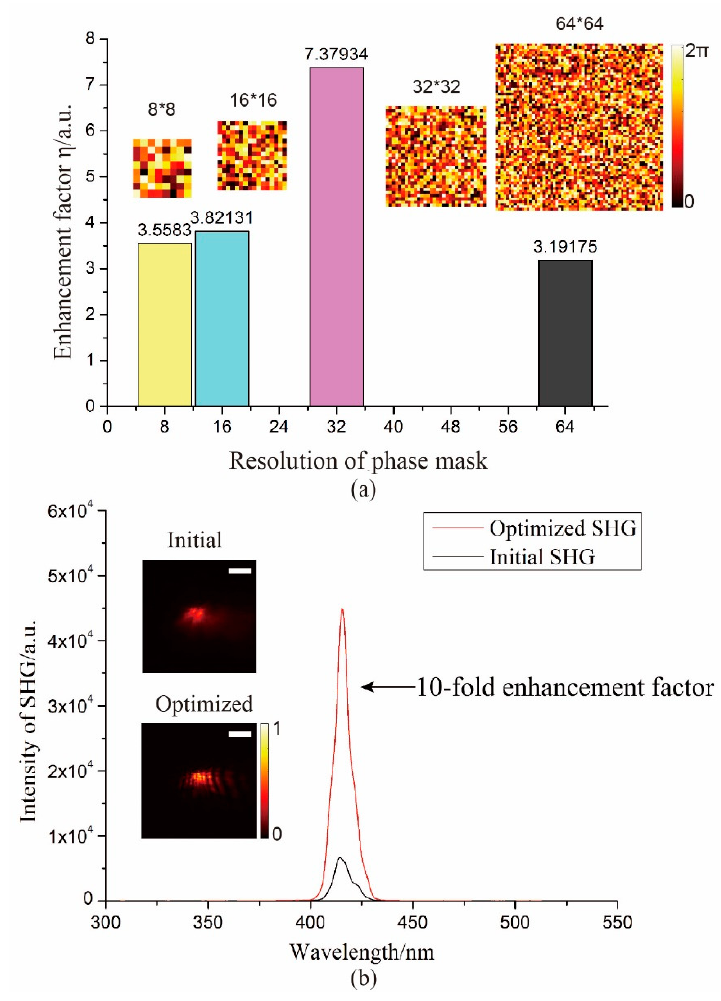
Figure 2. The enhancement of SHG without scattering medium using wavefront shaping technique. ( a ) Comparison of enhancement effects of different phase mask resolutions (results from the statistical average values of multiple experimental data). ( b ) Comparison of the second harmonic spectrum before and after optimization (detecting the spectrum of the best results). Note: the optimized light field is collected after three times attenuation. Scale bar: 1.468 mm.